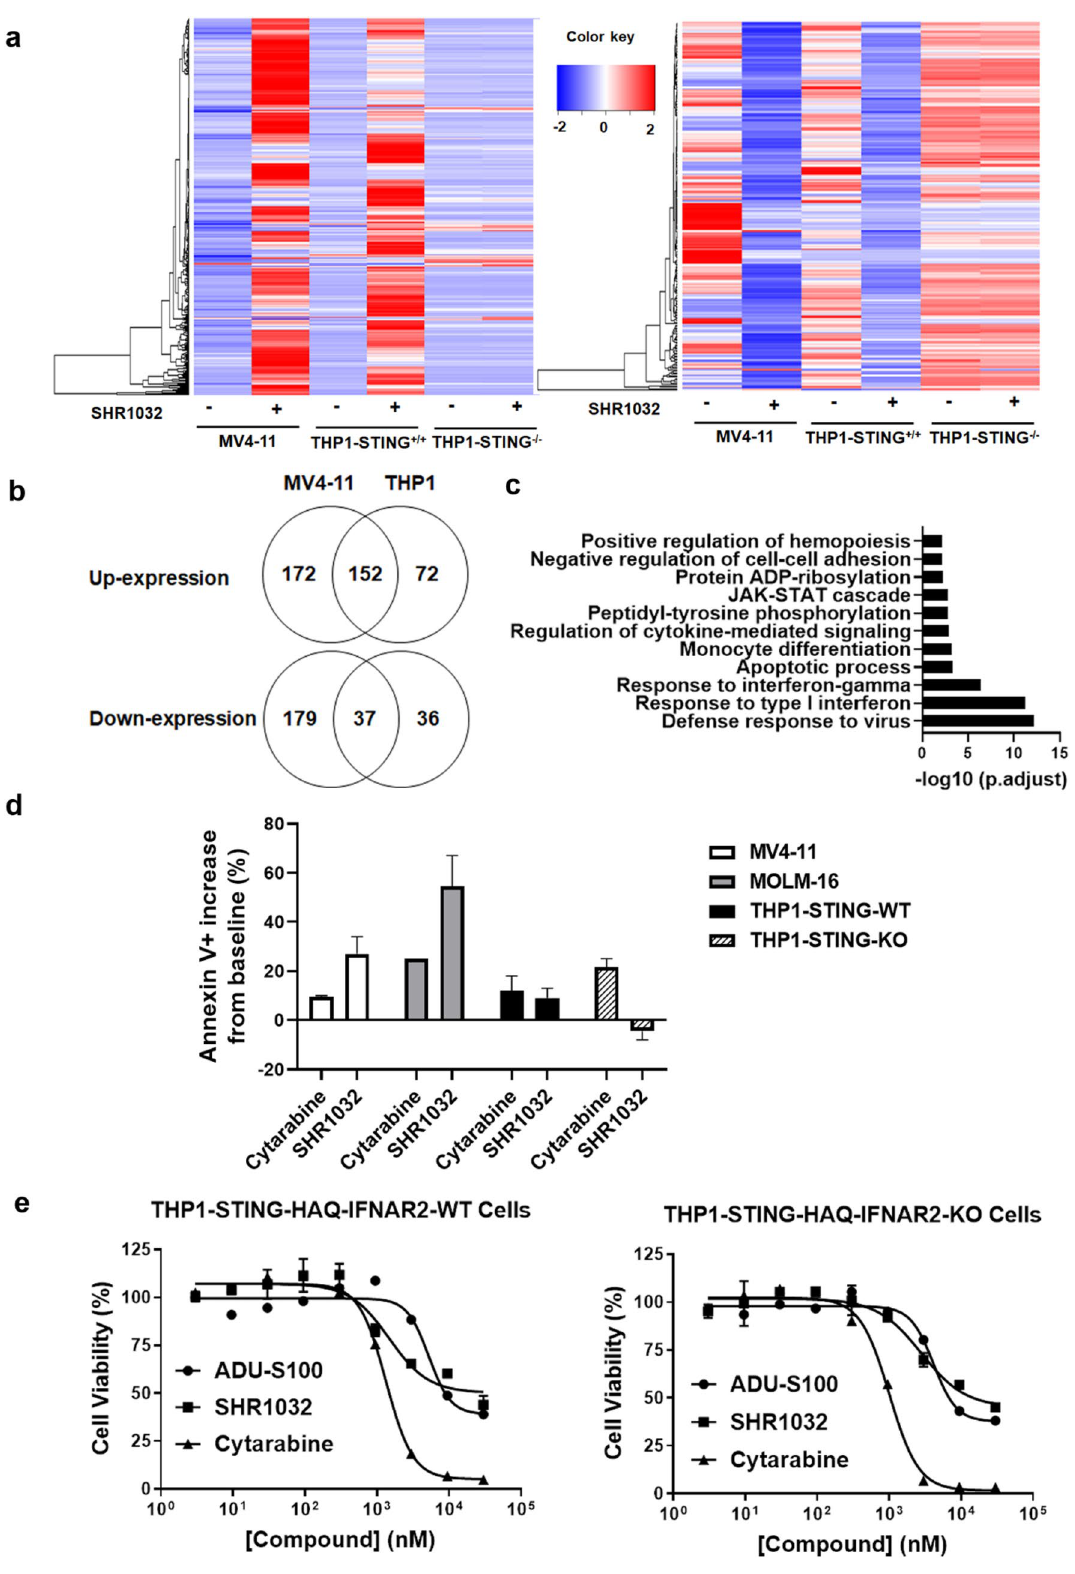
Figure 5. Cell apoptosis induced by SHR1032 in AML cell lines is independent of type I interferon. ( a – d ) RNA-Seq analysis of THP1-STING-R232, THP1-STING-KO and MV4-11 AML cells treated with 1 µM of SHR1032 for 4 h. ( a ) Heatmaps showing gene expression patterns of upregulated (left) or downregulated (right) DEGs with SHR1032 treatment. ( b ) Venn diagram showing genes up- (above) or down-regulated (below) genes in MV4-11 and THP1-STING-R232 cells with SHR1032 treatment. ( c ) Gene Ontology analysis of those genes up-regulated in both MV4-11 and THP1-STING-R232 cells. ( d ) ANNEXIN V staining analysis with flow cytometry in MV4-11, MOLM-16, THP1-STING-WT and THP1-STING-KO cells. ( e ) Cell viability analysis by CellTiter Glo in THP1-IRFAR2-WT or -KO